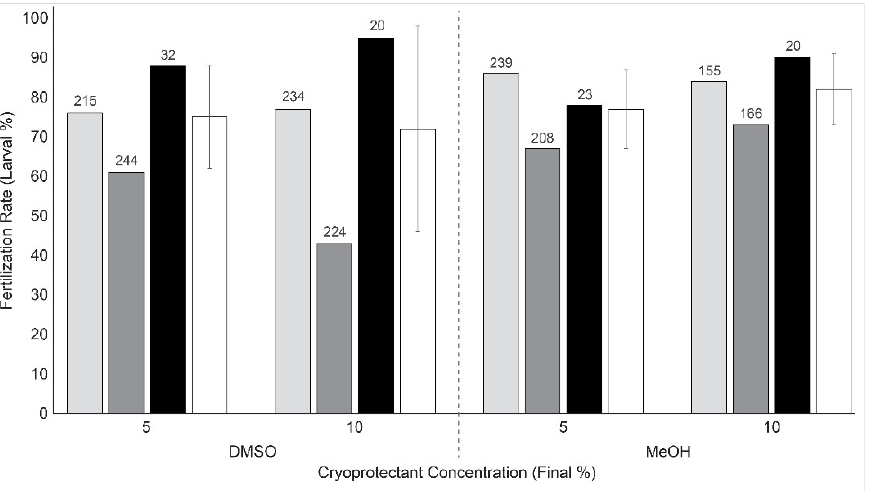
Figure 5. Fertilization rate of Hydractinia eggs by use of sperm cryopreserved using the CryoKit with various cryoprotectant conditions ( n = 3). Fertilization rate is reported as larval percentage calculated by dividing the number of larvae by the initial number of eggs. Light grey bars represent replicate 1, dark grey bars represent replicate 2, black bars represent replicate 3, and white bars represent the mean (±SD) of the three replicate trials. Numbers above the bars indicate the initial number of eggs counted. DMSO: dimethyl sulfoxide; MeOH: methanol.